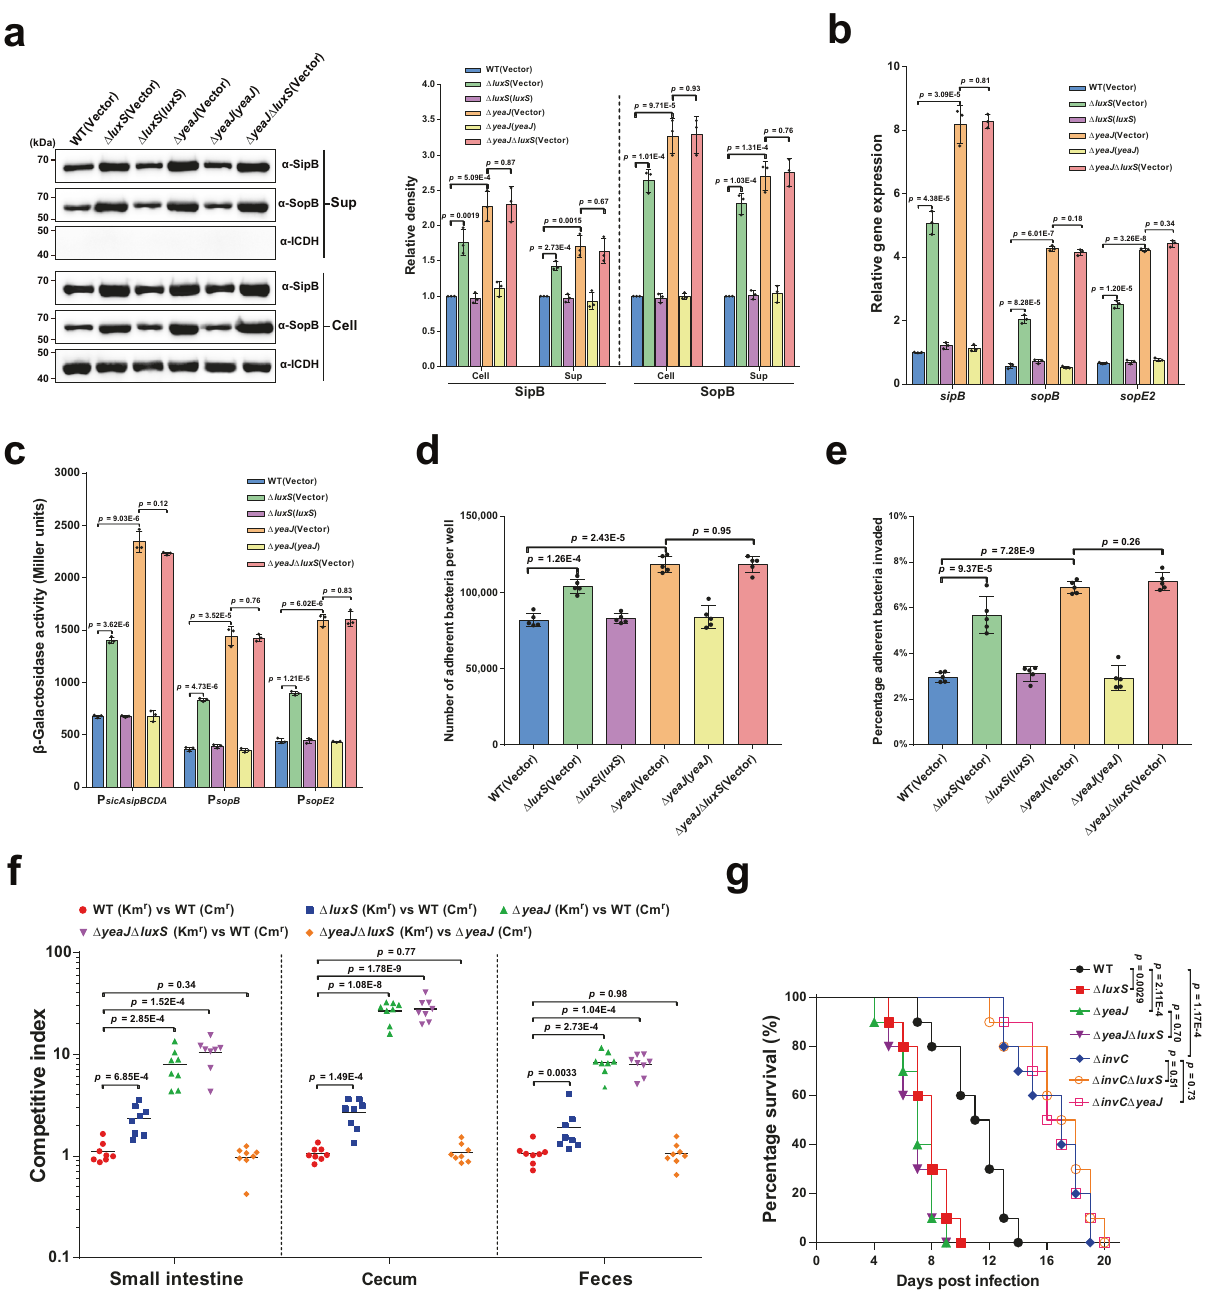
Fig. 3 | AI-2 represses the T3SS-1 and negatively regulates the virulence of S . Typhimurium via YeaJ. a AI-2 negatively regulates intracellular accumulation and secretionofSipBandSopBviaYeaJ.Cellpellet(Cell)andconcentratedsupernatant (Sup) were probed for SipB and SopB by western blot analysis. Isocitrate dehy- drogenase (ICDH) was probed as a loading control. The blots shown are repre- sentative of three independent experiments with similar results. The band intensities were quanti fi ed by scanning densitometry using ImageJ (NIH, USA), normalized to intracellular ICDH, and presented as values relative to that of the wildtype (mean±s.d.; n =3 independent experiments). b mRNA levels of T3SS-1 genes were determined by qRT-PCR analyses. Expression was normalized to 16S rRNA and reported as fold change relative to that of the sipB gene of the wildtype. Data were mean±s.e.m. of three independent experiments. c The promoter activities of T3SS-1 genes measured using β -galactosidase activity assays (mean± s.e.m.; n =3 independent experiments). d , e , Adherence to ( d ) and invasion of ( e )